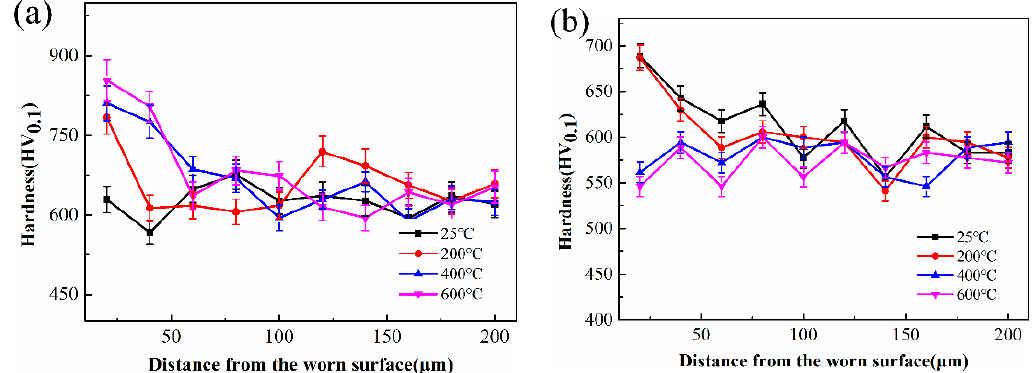
Figure 8. The microhardness profiles along the cross-section of the bottom of worn surface: ( a ) CoCrAlYTa-10%Al 2 O 3 coating; ( b ) H13 steel.